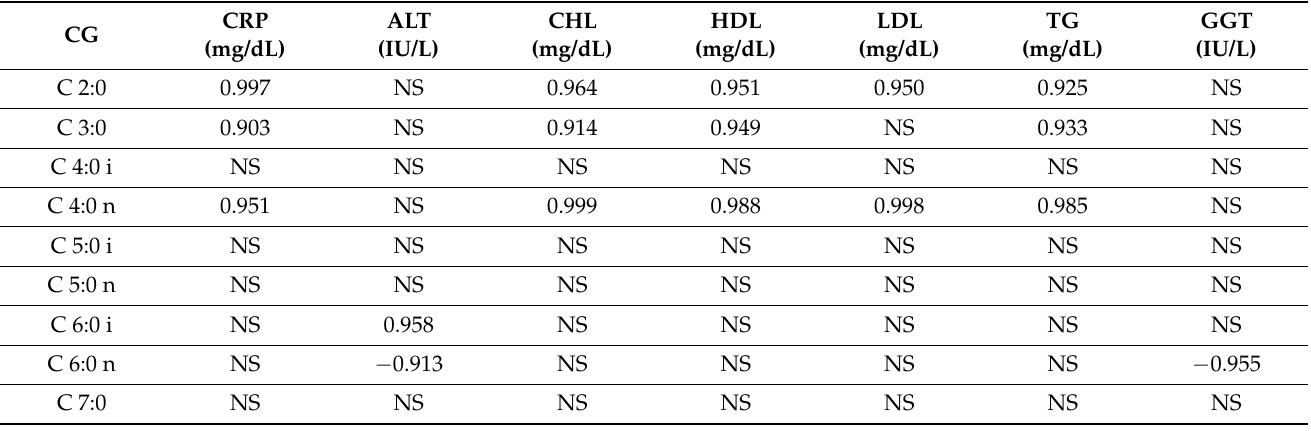
Table 2. Correlation coefficients indicating the extent to which SCFAs in the stool and the examined plasma parameters in the CG are interdependent.